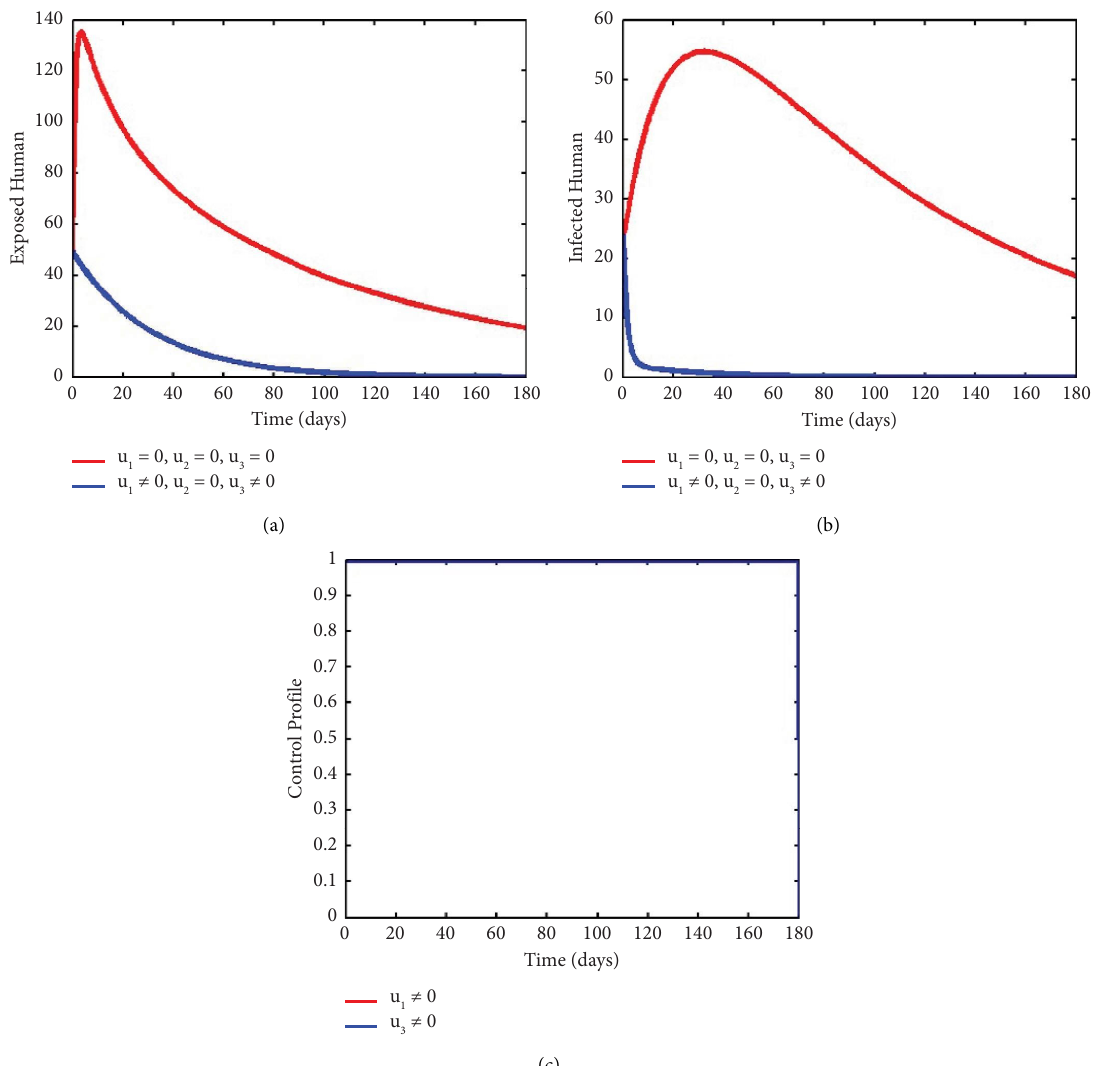
and treatment of infected u 1